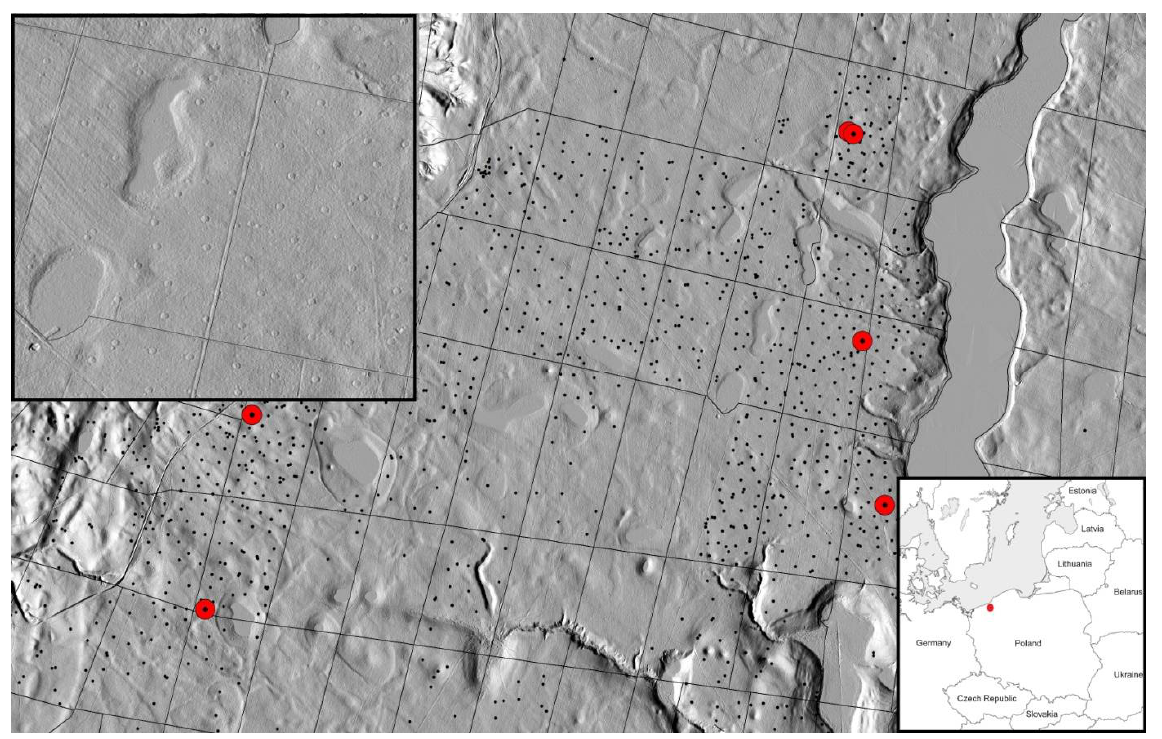
Figure 1. Localization of study plots in Manowo Forest District, northern Poland (black point-relict charcoal hearths localization; red point–study plots localization).